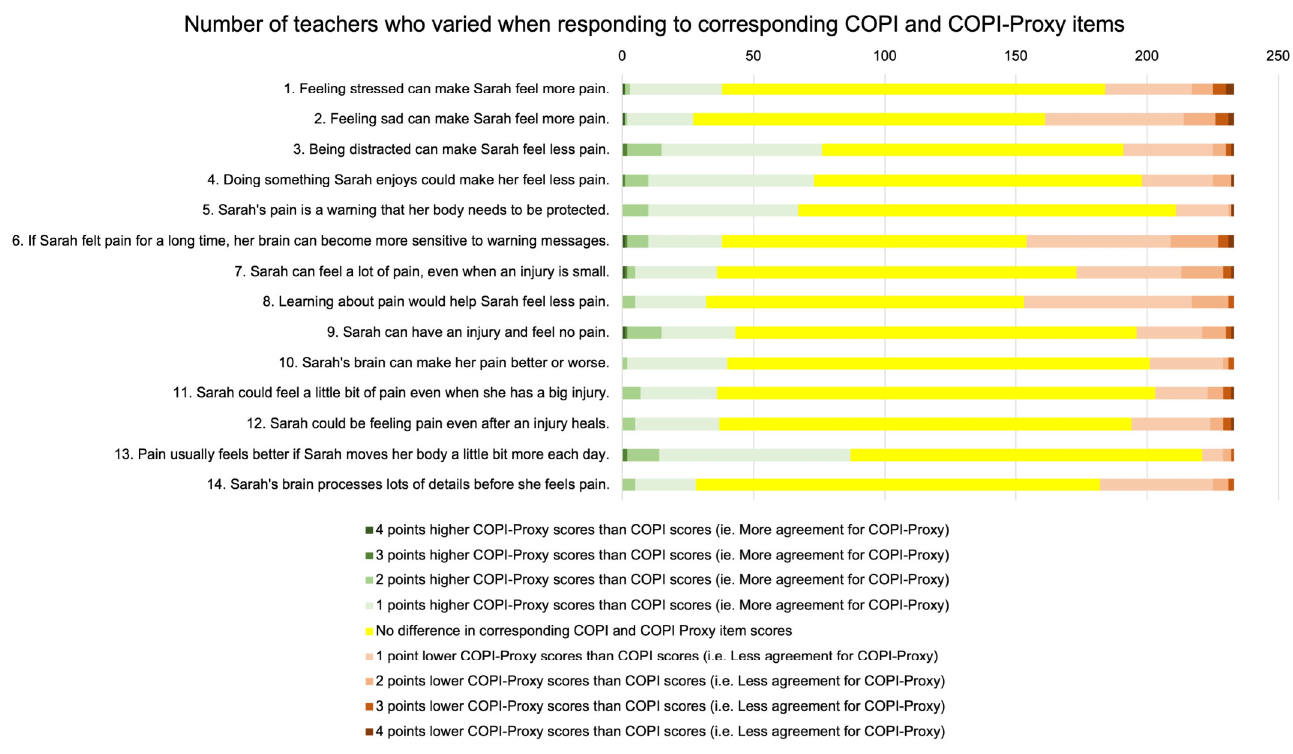
Figure 2. Number of teachers who varied when responding to corresponding COPI and COPI-Proxy items.